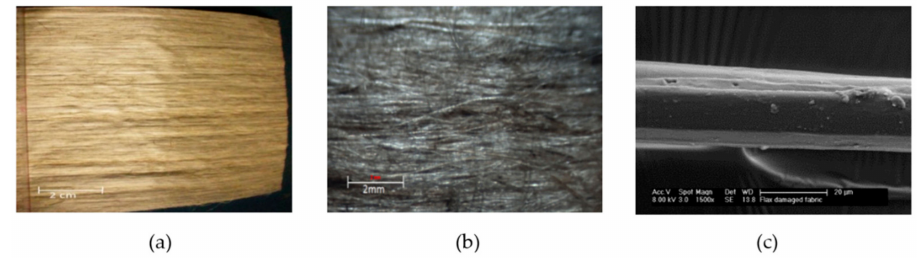
Figure 1. ( a ) Digital photographic image of flax tape. ( b ) Optical micrograph of flax tape ( × 10). ( c ) Scanning electron micrograph ( × 1500) of a flax fiber from the tape.